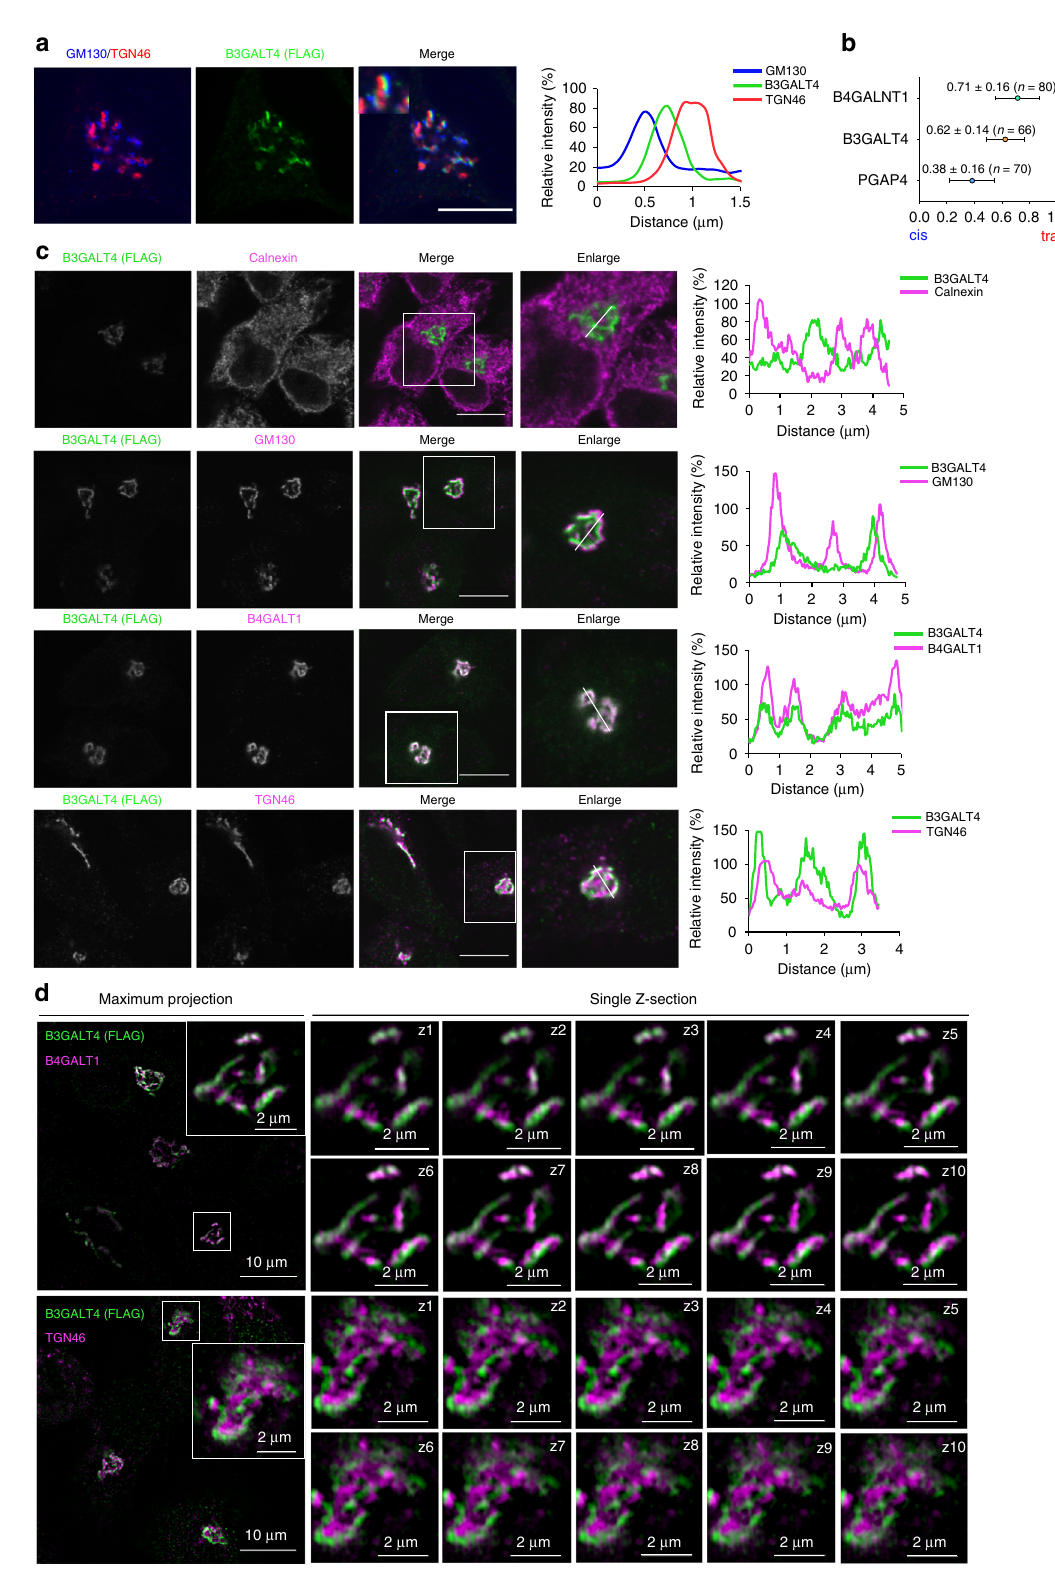
B3GALT4 was co-localized with B4GALT1 and partially co- localized with TGN46 (Fig. 5c). We then used super-resolution 3D structured illumination microscopy to compare localization patterns of FLAG-tagged B3GALT4 and endogenous markers for trans-Golgi cisterna (B4GALT1) and TGN (TGN46),